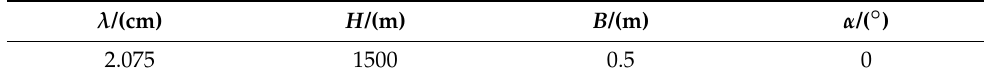
Figure 3. Interference phase versus elevation values. ( a ) InSAR system geometric model. ( b ) Simulation of the relationship between the interference phase and elevation value. Table 1. Simulation